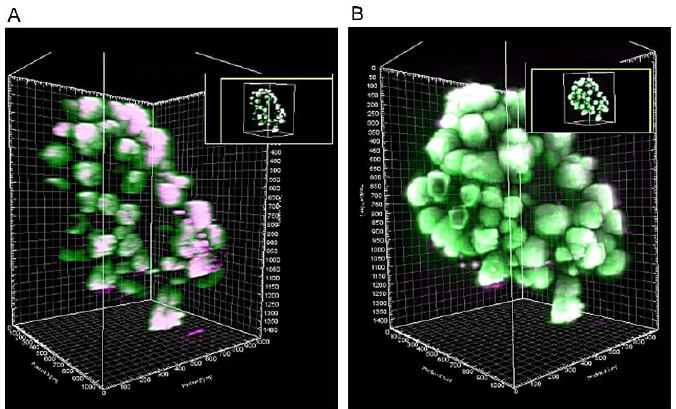
Figure 4. Reconstructed 3D voxel image for the developed bronchial tree. The bronchial tree was stained for expression of actin and FGFR2. The scanned area measured 1087 × 1450 × 1087 µm. ( A ) Image reconstructed from scanning data taken at a single side. Signals corresponding to both actin and FGFR2 could not be detected from half the developed branches. ( B ) Image reconstructed from scanning data taken from six sides. The fluorescent intensities were averaged to show the capability of the gel cube device. The entire structure could be clearly observed by staining for actin and FGFR2.